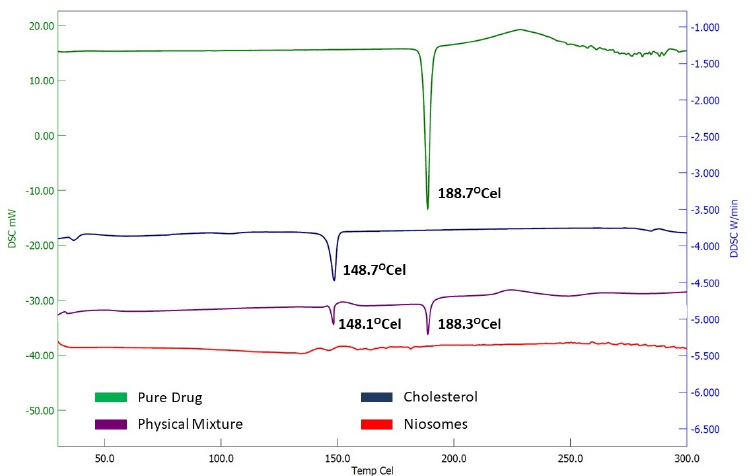
Figure 7. Di ff erential scanning calorimetric graph of levosulpiride, cholesterol, physical mixture, and niosomes formulation (NC).